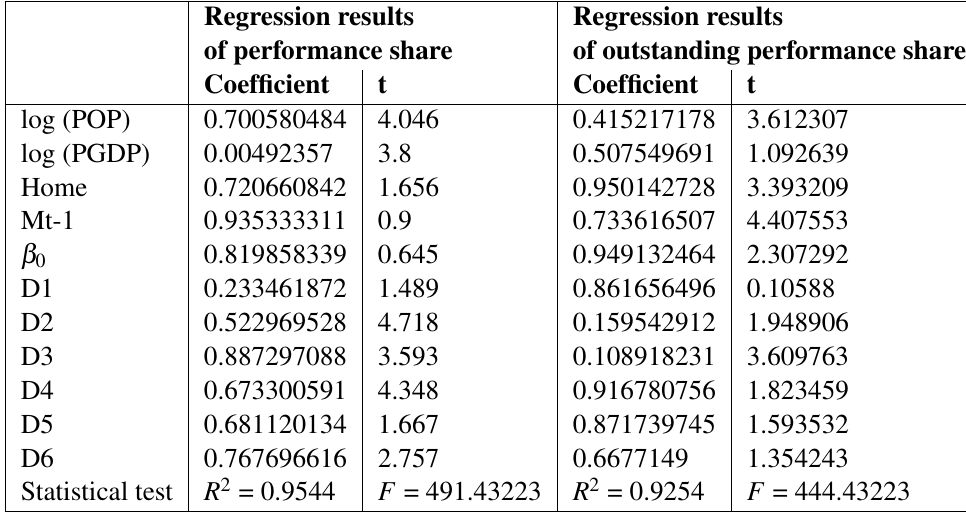
Table 2 Summary of the regression results of the share of outstanding and excellent results in college sports from 2014 to